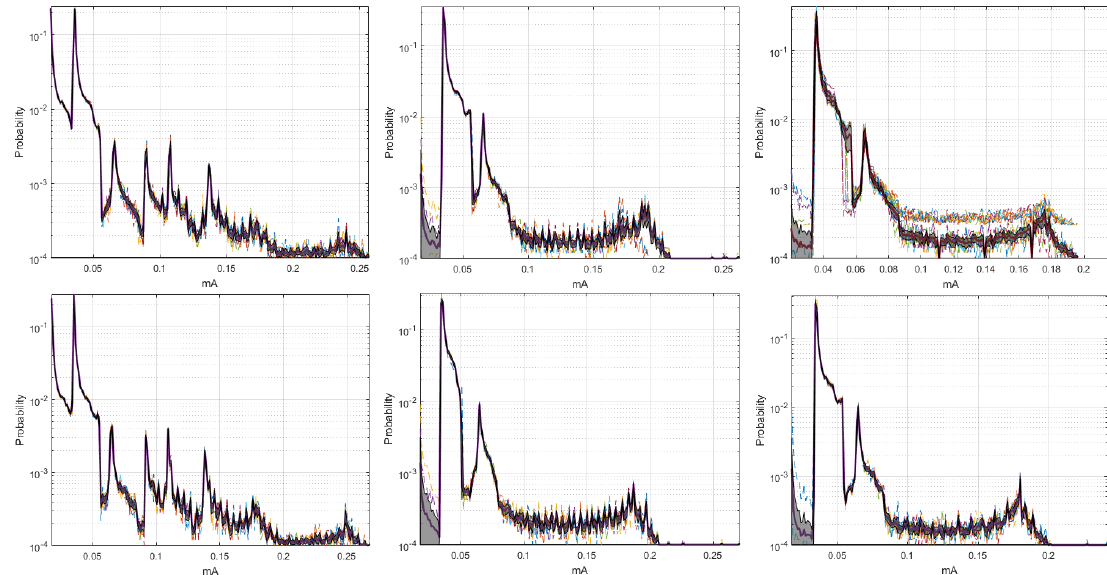
Figure 12. CI of pdf for ZigBee network. From left to right: at 9600, 19,200, and 57,600 bauds. From top to bottom: Coordinator Node and Nodes 1 to 3.